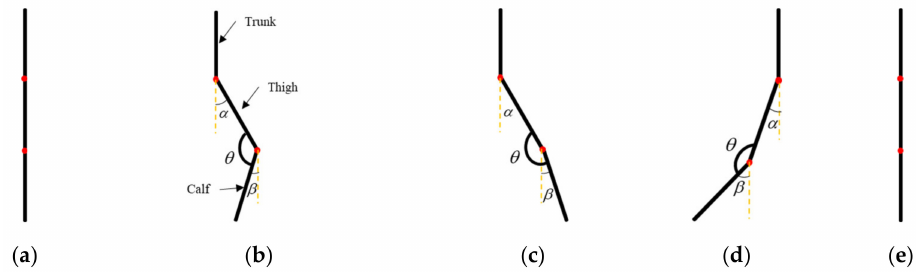
Figure 2. Relative position model of lower limb. ( a ) α = 0, β = 0; ( b ) α > 0, β < 0; ( c ) α > 0, β > 0; ( d ) α < 0, β < 0; ( e ) α = 0, β =